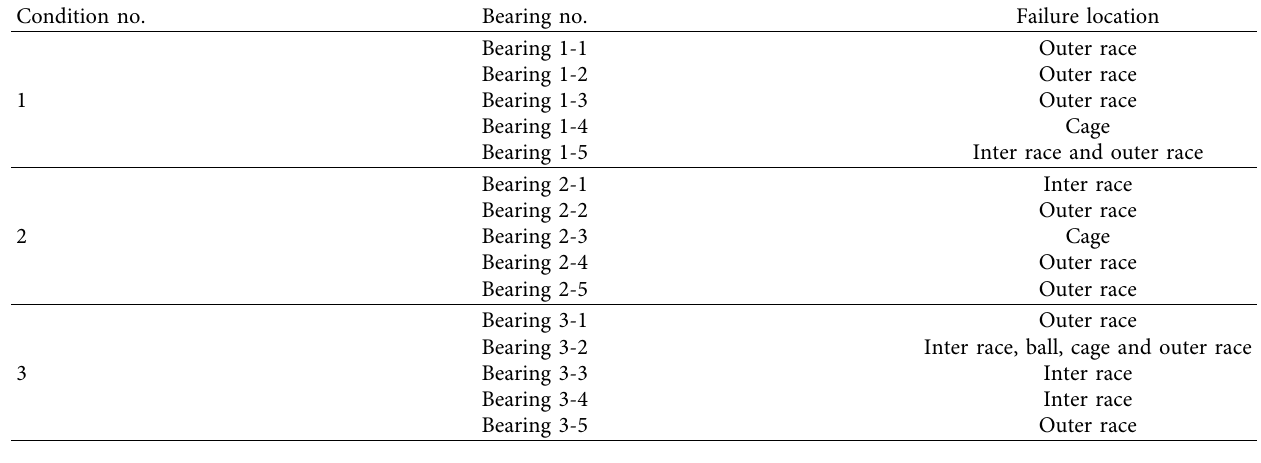
Table 2: Information on the failure of diferent bearings.